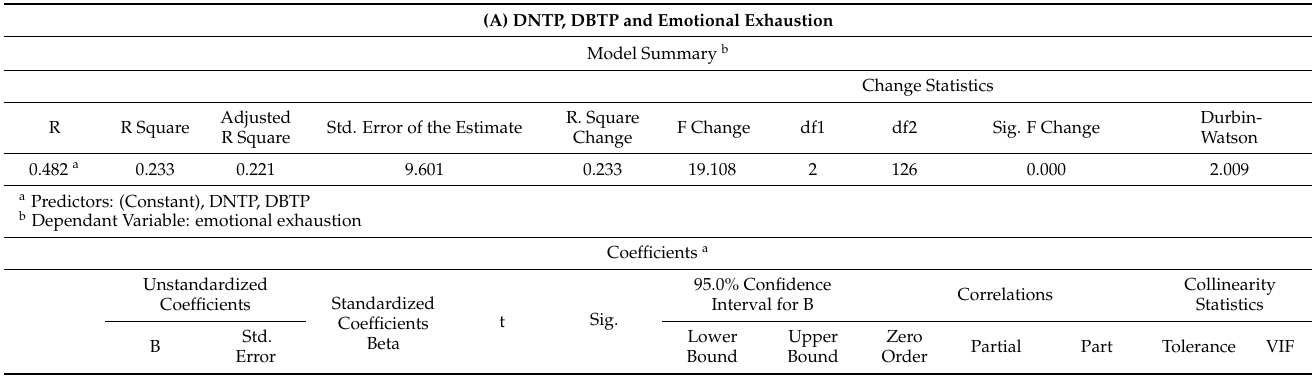
Table 6. Linear regression of Emotional